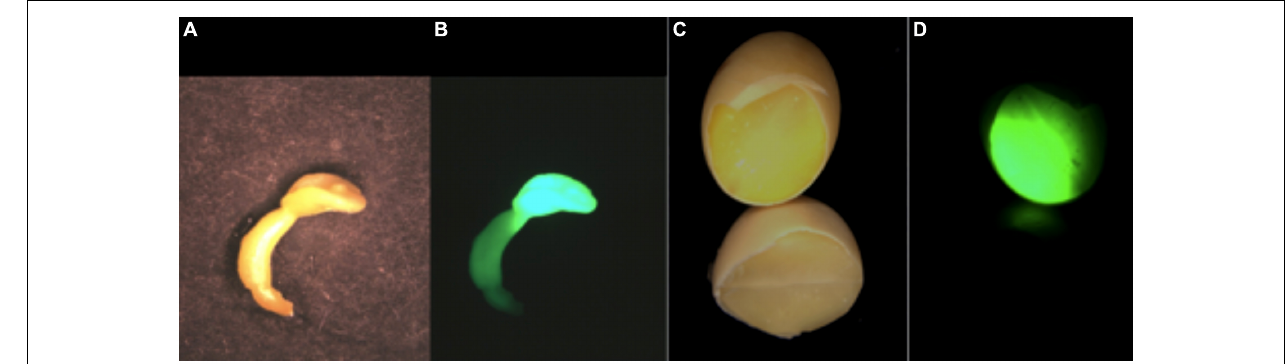
as a chipped seed illuminated with white light (C) and UV for GFP fluorescence (D) .The comparative expression the same glycinin promoter- regulated GFP in somatic embryos and seeds shows that while somatic embryos are a good proxy for seed expression there are challenges in interpreting somatic embryo results as an accurate proxy for a seed’s in planta protein content and